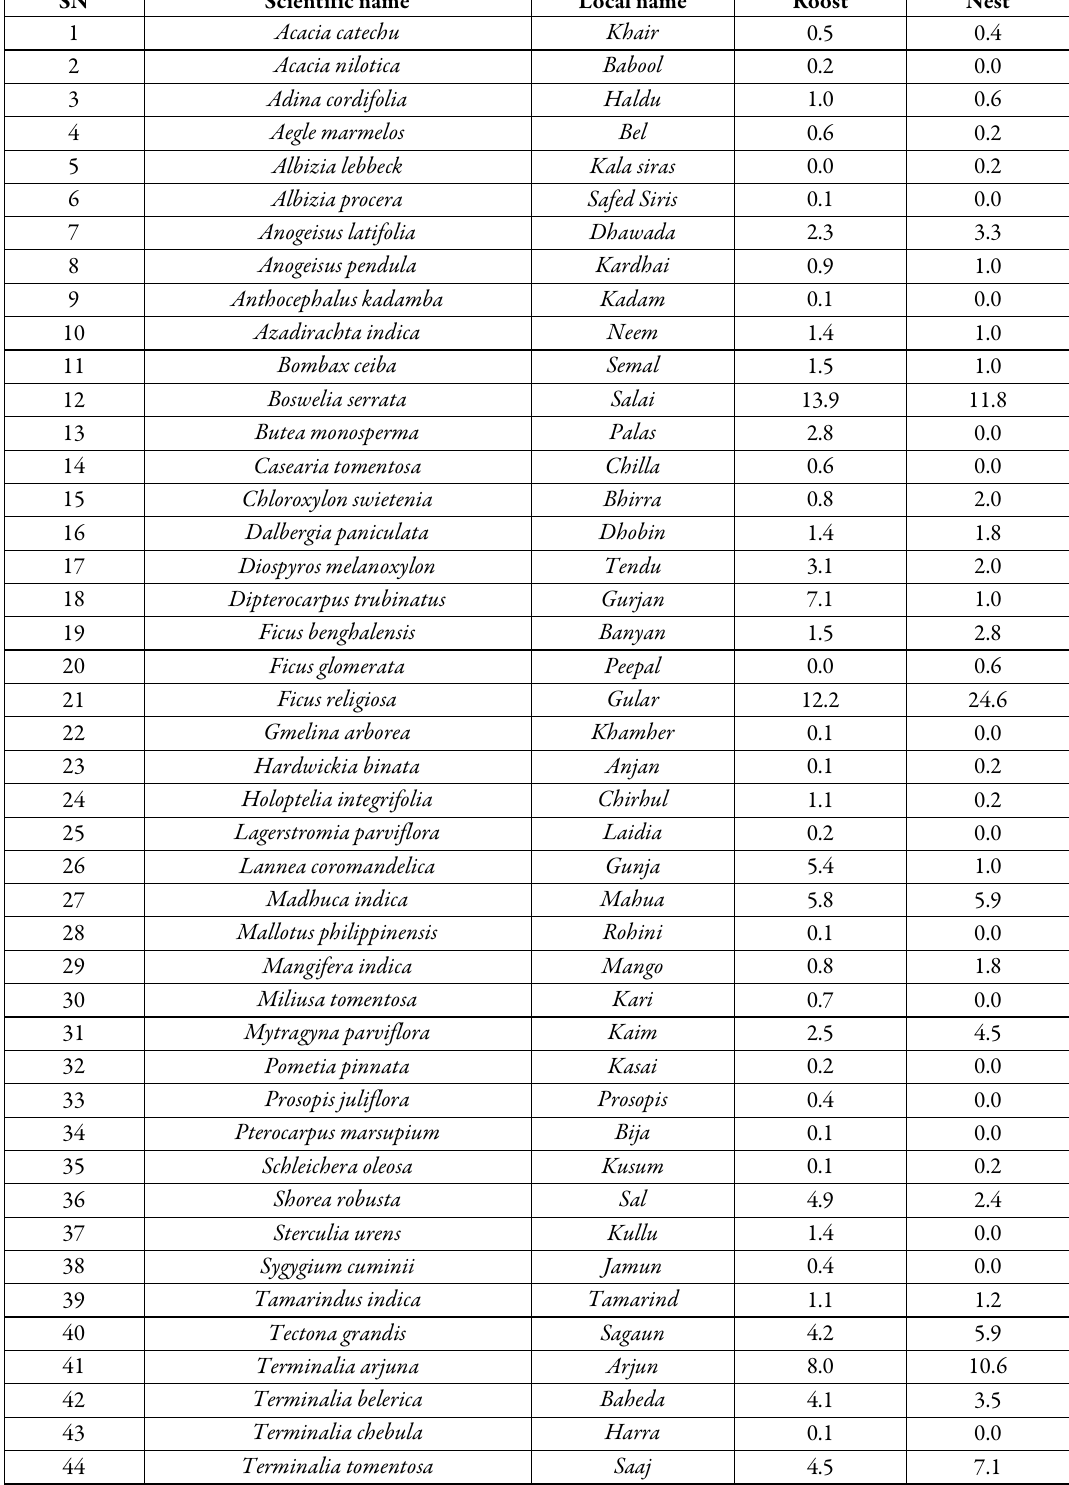
Table 4. Different tree species with their relative frequency of hosting the roost and nest of vultures